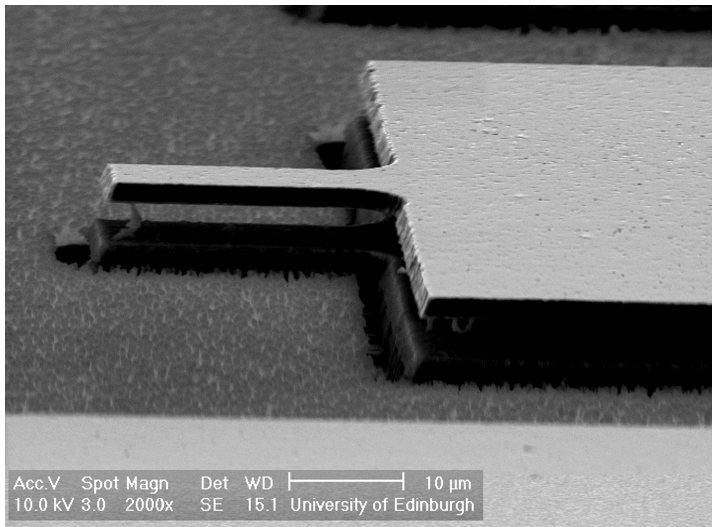
Figure 8. SEM image of the SiC cantilever [45]. Reprinted from Microelecton. Eng., 78–79, Jiang et al., Dry release fabrication and testing of SiC electrostatic cantilever actuators, 78–79, c (cid:13) 2005, with permission from Elsevier.